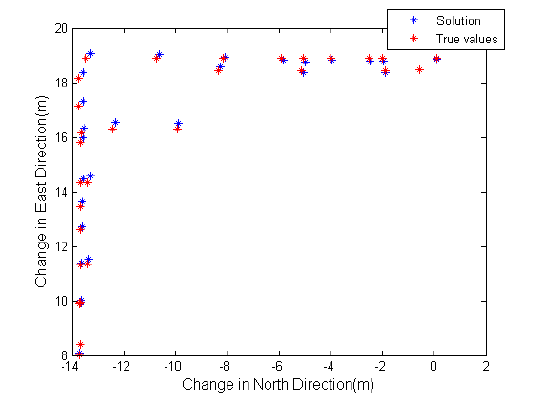
Figure 12. Mapping solution using two control points North East Up